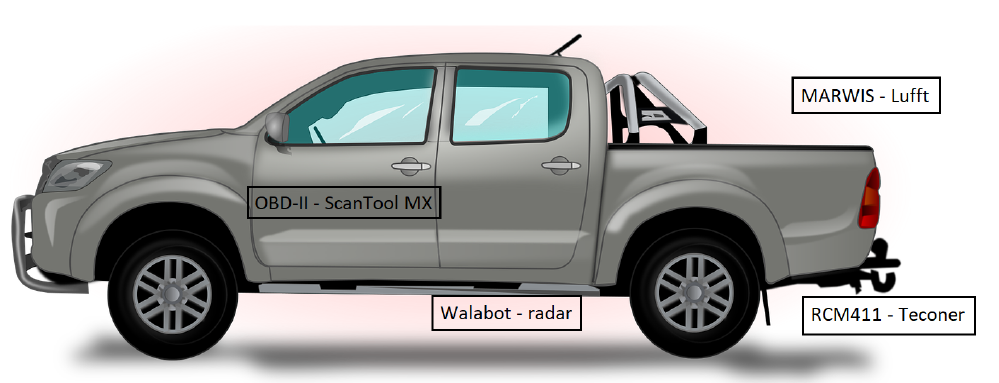
Figure 1. Placement of the sensors on the car. Image by OpenClipart-Vectors from